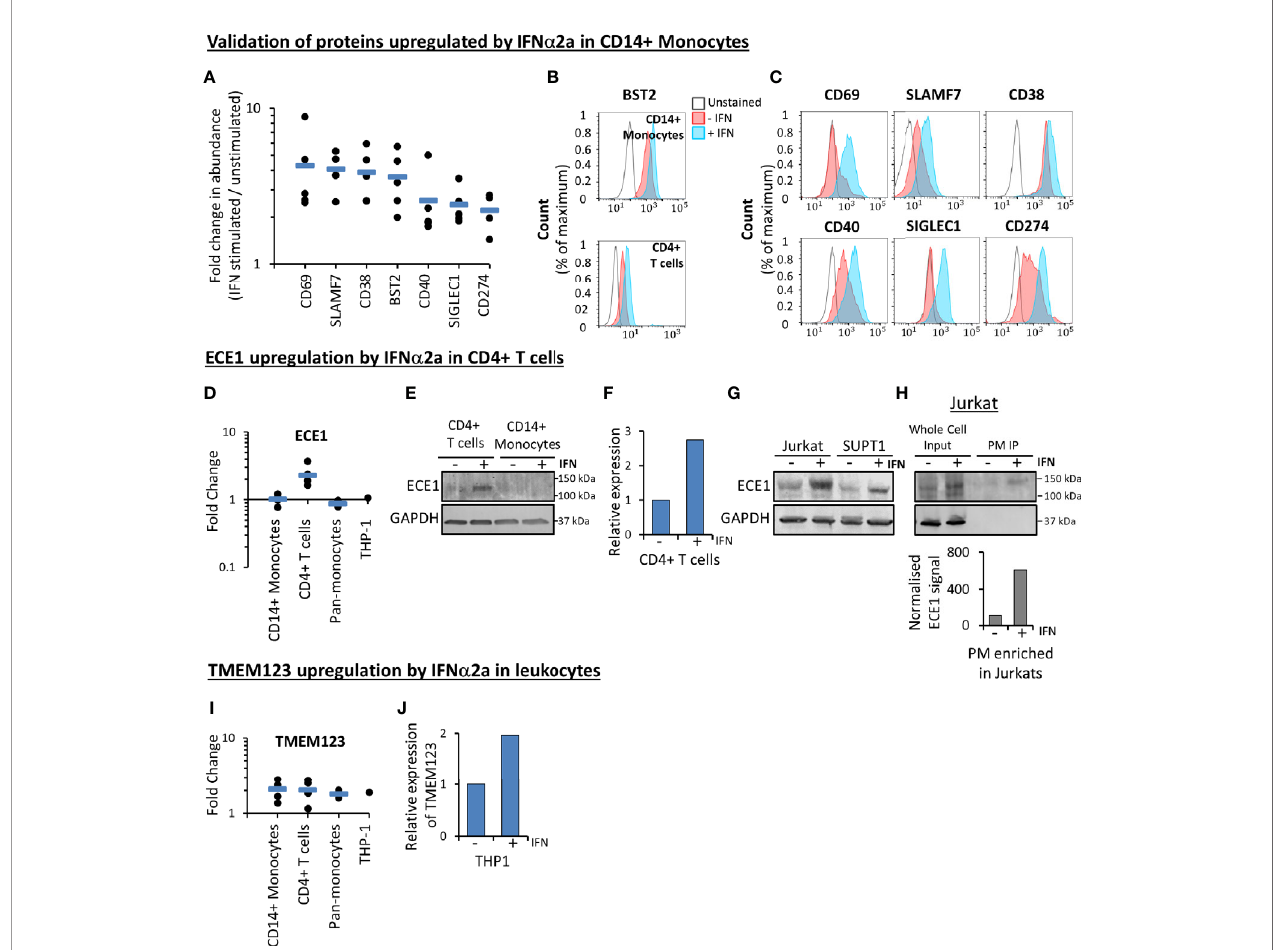
FIGURE 5 | Validation of proteomic data. (A) Proteomic quantitation of a subset of proteins stimulated by IFN a 2a in primary CD14+ monocytes. Each point represents a single donor. Data is a subset of that shown in Figure 3A , and Table S1 . (B) Flow cytometry-based validation of IFN a 2a-stimulated change in BST2 expression at the surface of primary CD14+ monocytes (top) and CD4+ T cells (bottom). Similar data from an additional donor is shown in Figure S7A . (C) Validation by fl ow cytometry of a selection of proteins stimulated by IFN a 2a in primary CD14+ monocytes. Early activation antigen CD69, CD38, CD40, sialoadhesin SIGLEC1 and programmed cell death 1 ligand 1 (CD274) were quanti fi ed in CD14+ monocytes from one donor, while SLAMF7 was quanti fi ed in cells donated by a second individual. Red (unstimulated) and blue (stimulated with IFN a 2a) coloring as in Figure 5B . For SLAMF7 staining, the gray line represents a control sample stained only with secondary antibody (anti-mouse-AF647). For all other samples, the gray line represents unstained samples as directly conjugated antibodies were employed. Similar data from two additional donors is shown in Figures S7B, (C). (D) Proteomic quantitation of cell surface ECE1 in different cell types. Full data is given in Table S1 . (E) ECE1 protein is upregulated in the whole cell protein lysate from IFN a 2a-stimulated primary CD4+ T cells. Data is from a single donor. (F) qPCR con fi rming IFN a 2a-stimulated upregulation of ECE1 in primary CD4+ T cells, at the level of mRNA (Data is from a single donor, with three technical replicates). (G) Immunoblot con fi rming IFN a 2a-stimulated upregulation of ECE1 in whole cell protein lysates from two cultured T cell lines Jurkats and SUPT1s (n=1). (H) Immunoblot after immunoprecipitation (IP) of biotinylated cell surface proteins con fi rming IFN a 2a-stimulated upregulation of ECE1 at the cell surface of Jurkat T cells. ‘ Whole cell input ’ represents protein lysates prior to PM enrichment, and ‘ PM IP ’ represents PM-enriched samples. For the quantitation shown in the bar chart below the immunoblot, signals from the ECE1 bands following immunoprecipitation were normalized according to the relative amounts of PM protein loaded on both lanes of the gel. This was measured using a total protein stain and quanti fi ed using Image Studio Lite (n=1). (I) Proteomic quantitation of cell surface TMEM123, demonstrating upregulation by IFN a 2a in all cell types. Full data is given in Table S1 . (J) TMEM123 upregulation by IFN a 2a was validated in THP-1s by qPCR (three technical